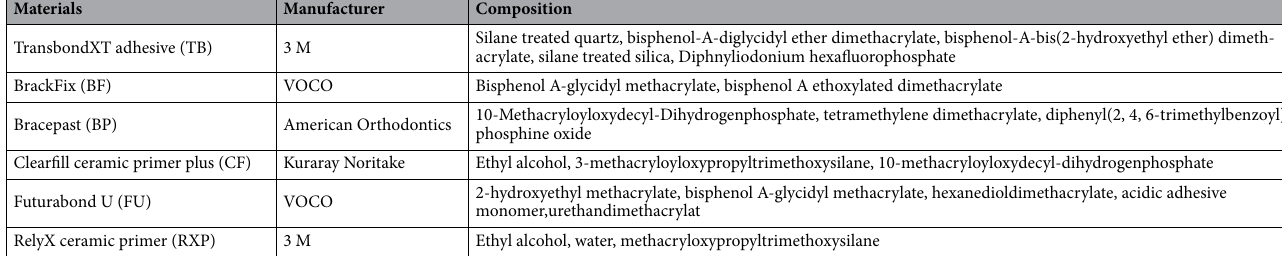
Table 1. Manufacturer and composition of the luting materials applied in the present study.